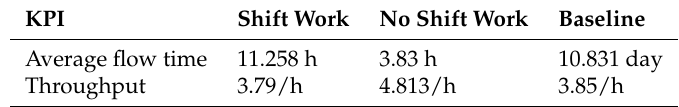
Table 3. Performance of the model when using shift work vs. not using shift work of 13